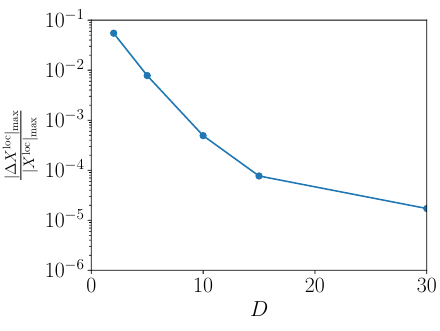
Figure 5: Fitting errors of X loc for the single-band Hubbard model on the square lattice at U = 1.5 W and β =